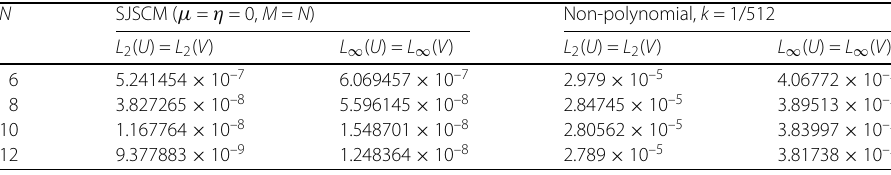
Table 3 L 2 and L ∞ error norms for u ( x , t ) = v ( x , t ) of Example 1 when 0 ≤ x ≤ 1, α 1 = α 2 = 0.7